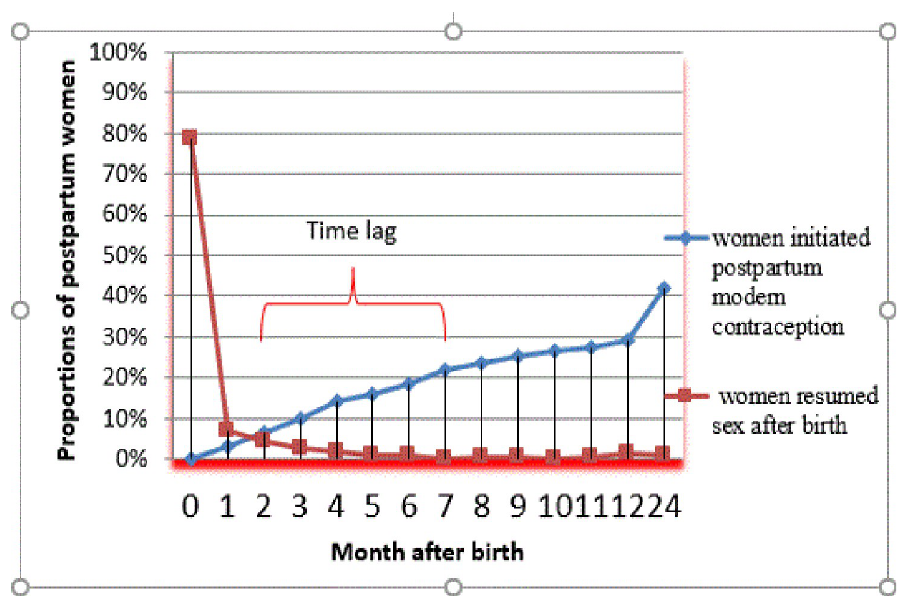
Fig 4. Relationship between resumption to sex and initiation of postpartum